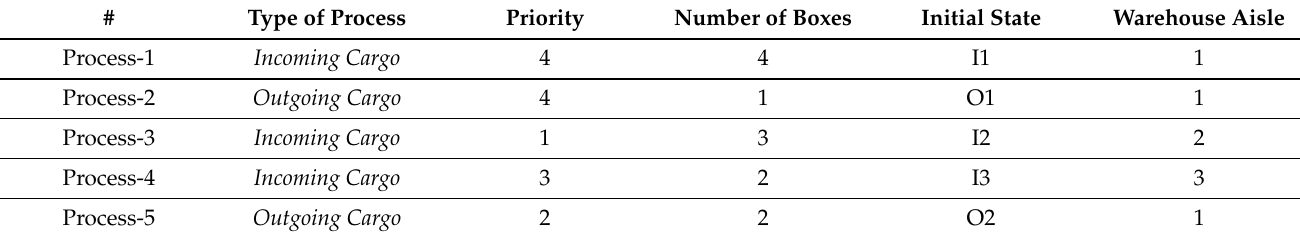
Table 4. Description of